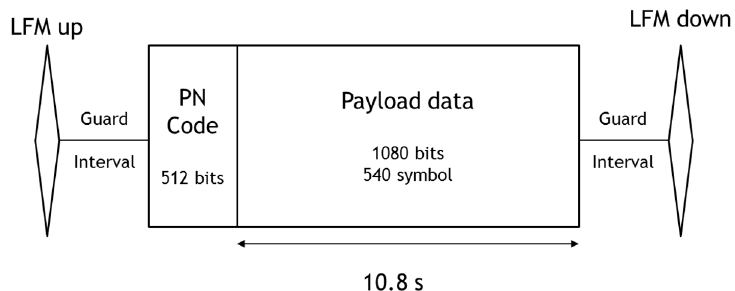
Figure 8. Packet Figure 8. Packet design. Figure 8. Packet design.